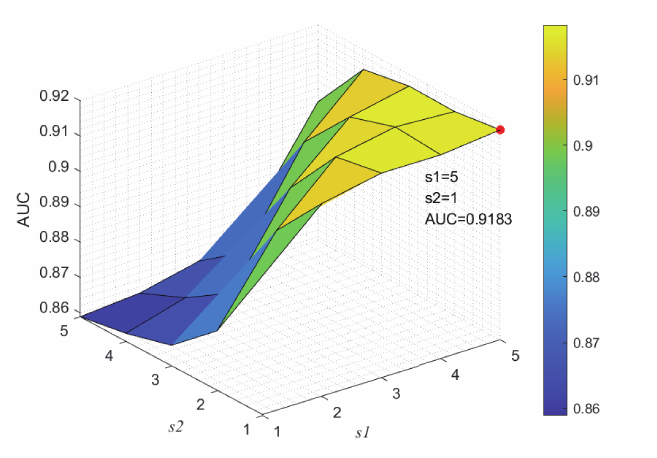
Figure 11. Joint sensitivity analysis of parameters k l and k d .